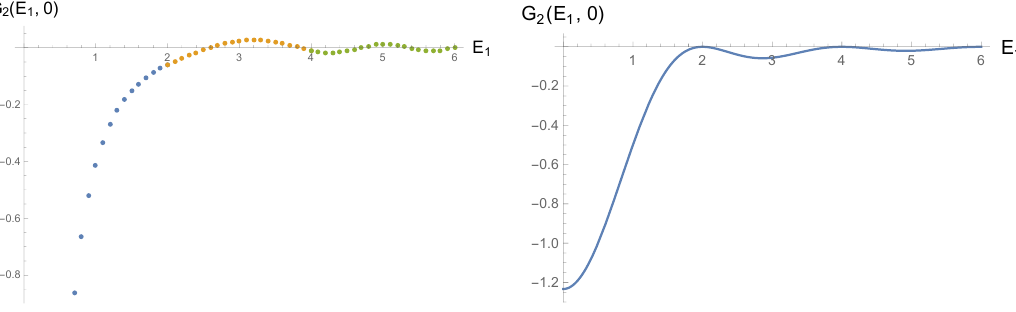
Figure 5 . The non-perturbative correlator for (cid:22) = 1 vs. the sine kernel. While they are qualitatively similar, there do exist di(cid:11)erences between